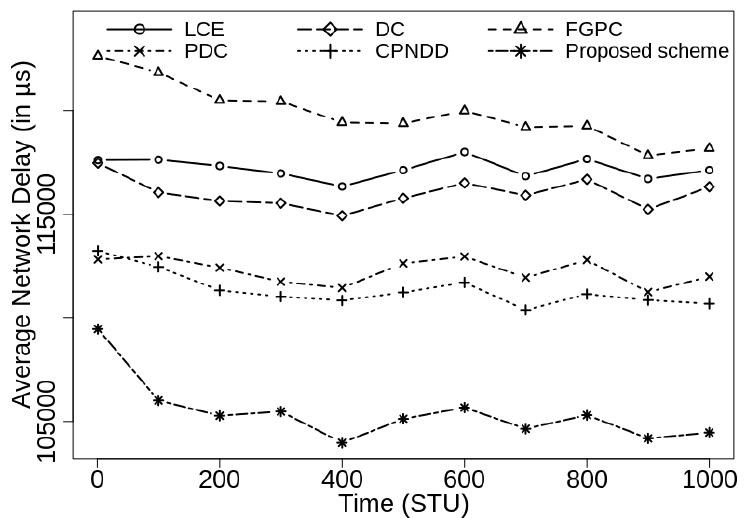
Figure 8. Comparison of average network delay (in µ s) with λ = 50/s, | CS ( R i ) | = 50, α = 0.7, and | Ctlg | =